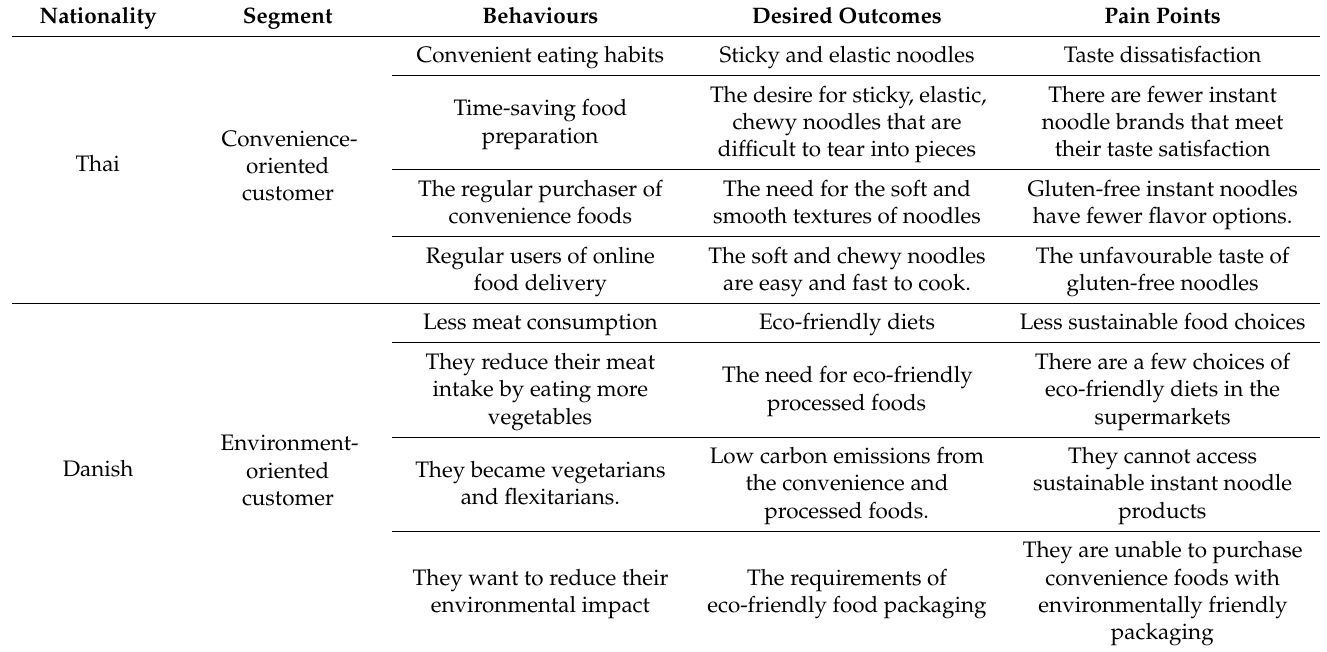
Table 4. Summary of the potential segment from each